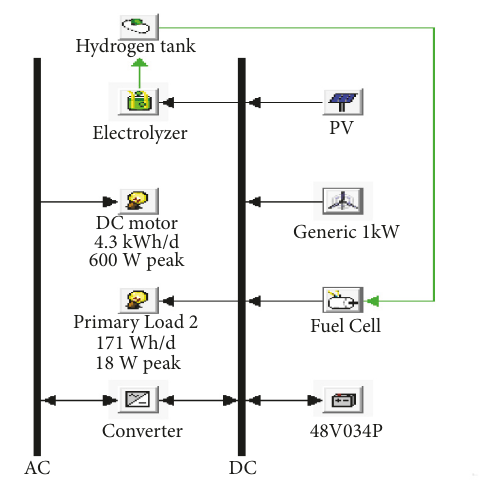
Figure 2: HOMER block